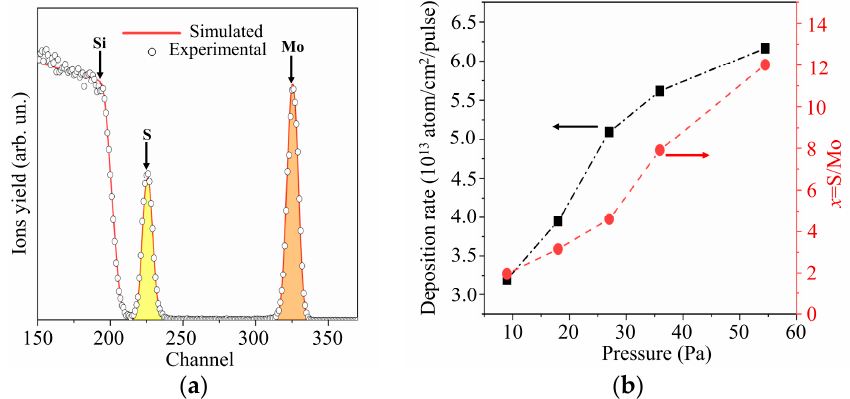
Figure 6. ( a ) The RBS spectrum for MoS x film obtained by RPLD on a Si substrate at an H 2 S pressure of 27 Pa; ( b ) deposition rates and compositions of MoS x films obtained by RPLD at different pressures of H 2 S gas.